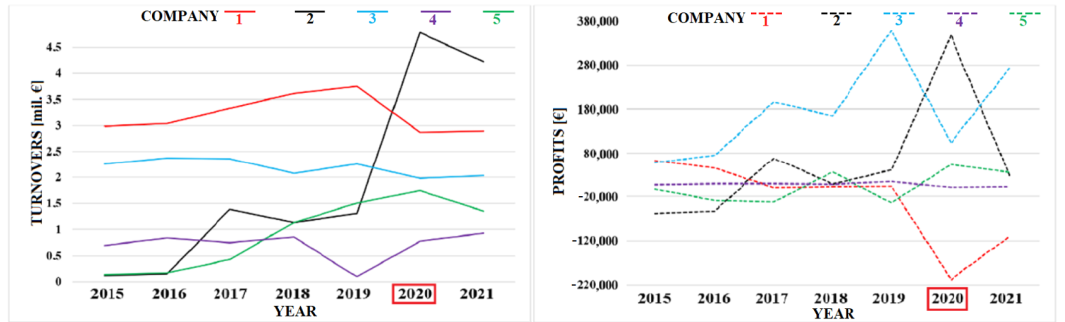
Figure 3. Development of profit and turnovers of the largest wine company in Slovakia [56].